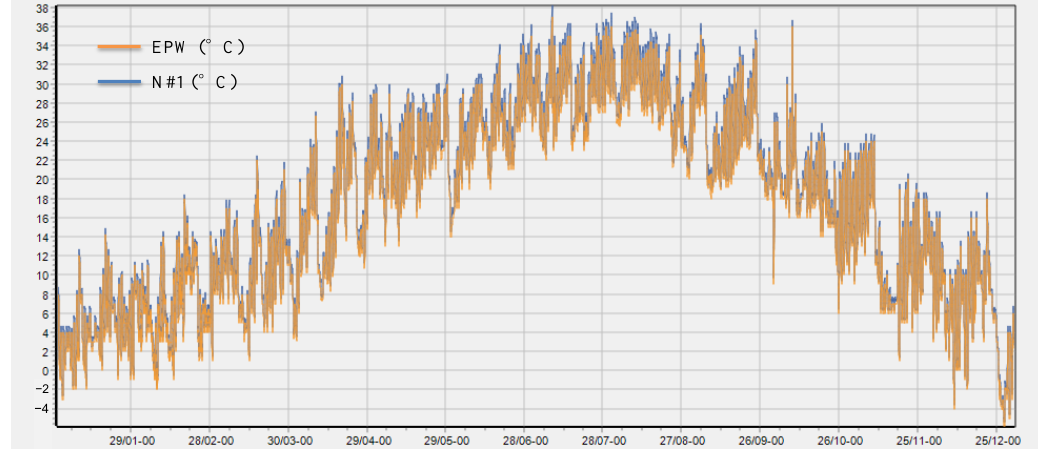
Figure 15. Air temperature of EPW and N#1.